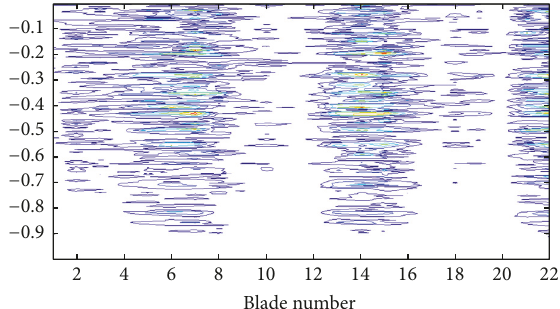
Figure 8: Correlation function map for the lag order as a function of blade number, corresponding to the impact test. The correlation is computed with respect to blade 1 ( 𝑛 = 1 ).